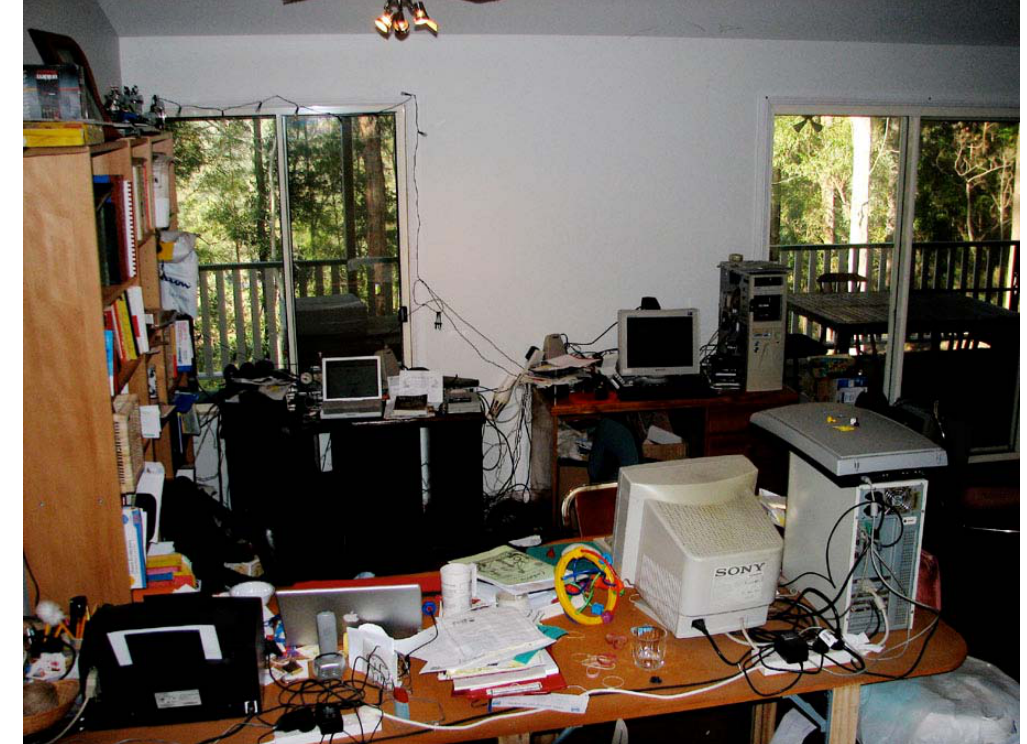
Figure 6: David de Groot’s computer room (courtesy David de